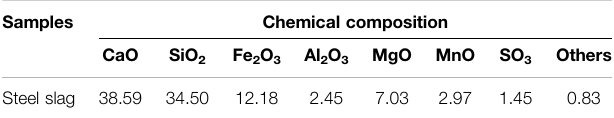
TABLE 2 | Chemical composition of steel